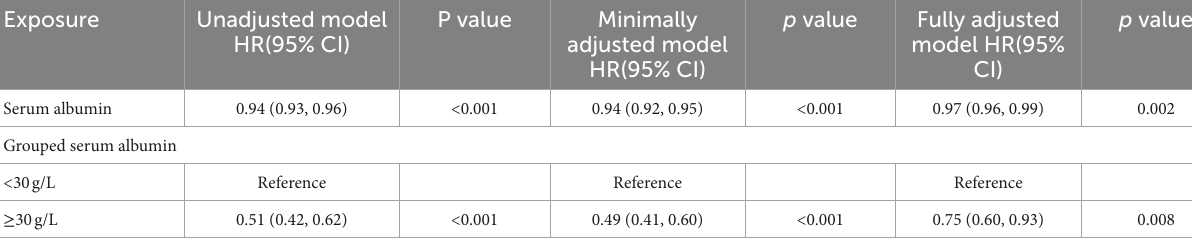
TABLE 2 Relationship between serum albumin and in-hospital mortality.